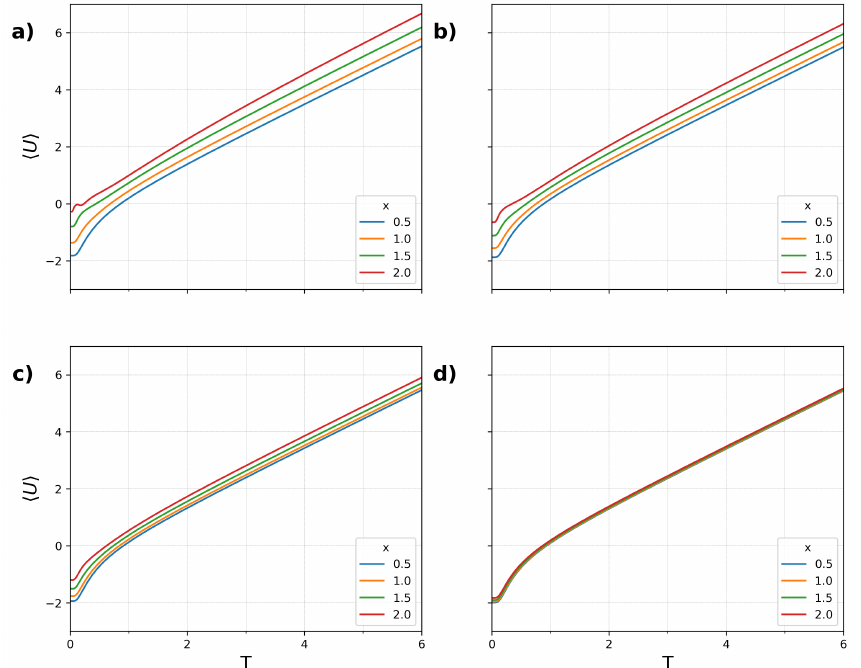
Figure 7. The results that we have obtained for the internal energy as a function of the temperature are presented in this Figure. The curves correspond to different values of the dimensionless coupling constant x , from the up to the down curve x takes the values 0.5, 1, 1.5, and 2, respectively. ( a – d ), stand for values of the asymmetry parameter α = − 1.25, − 1.0, − 0.75, and − 0.362,